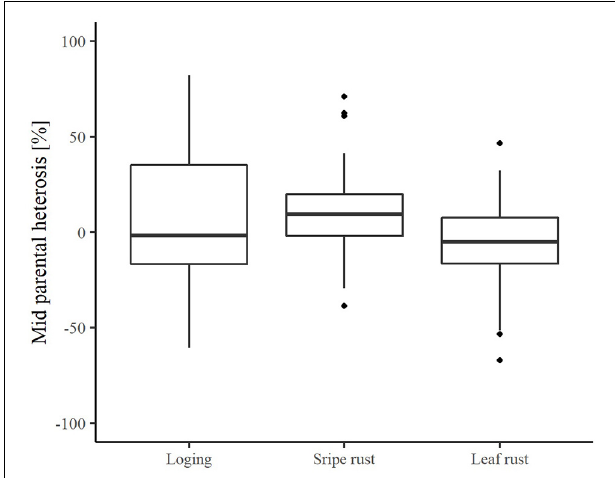
FIGURE 3 | The distribution of relative mid-parent heterosis for the traits lodging tolerance, yellow rust resistance, and leaf rust resistance in hybrid performance experiment.